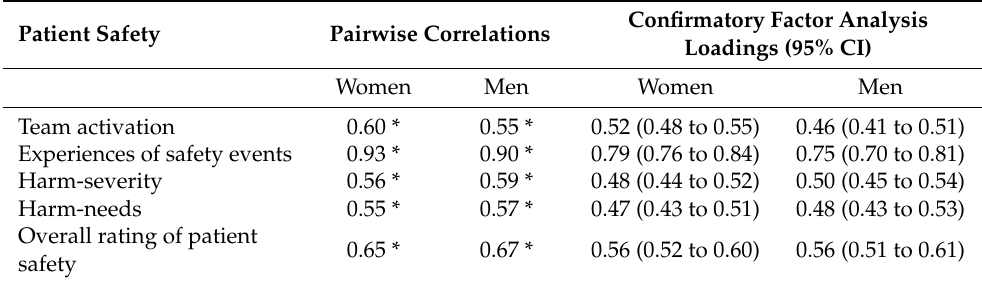
Table A3. Description of the patient safety latent variables: pairwise correlations between scales and the latent variables and loadings in the confirmatory factor